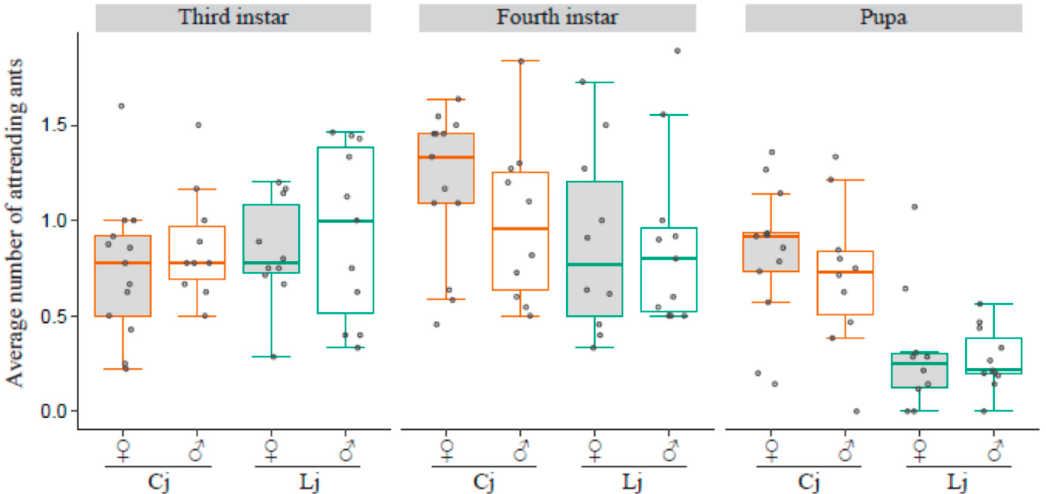
Figure 5. Number of tending ants for lycaenid larvae and pupae. The boxplots show the average number of tending ants for female (gray box) and male (white box) lycaenids in each developmental stage, third instar larvae, fourth instar larvae, and pupae. The colors of the box outlines and the dots represent ant-tending conditions (Cj: orange, Lj: green). All the data points are shown as dots. Dots outside boxes and whiskers are outliers. Different letters represent significant differences.